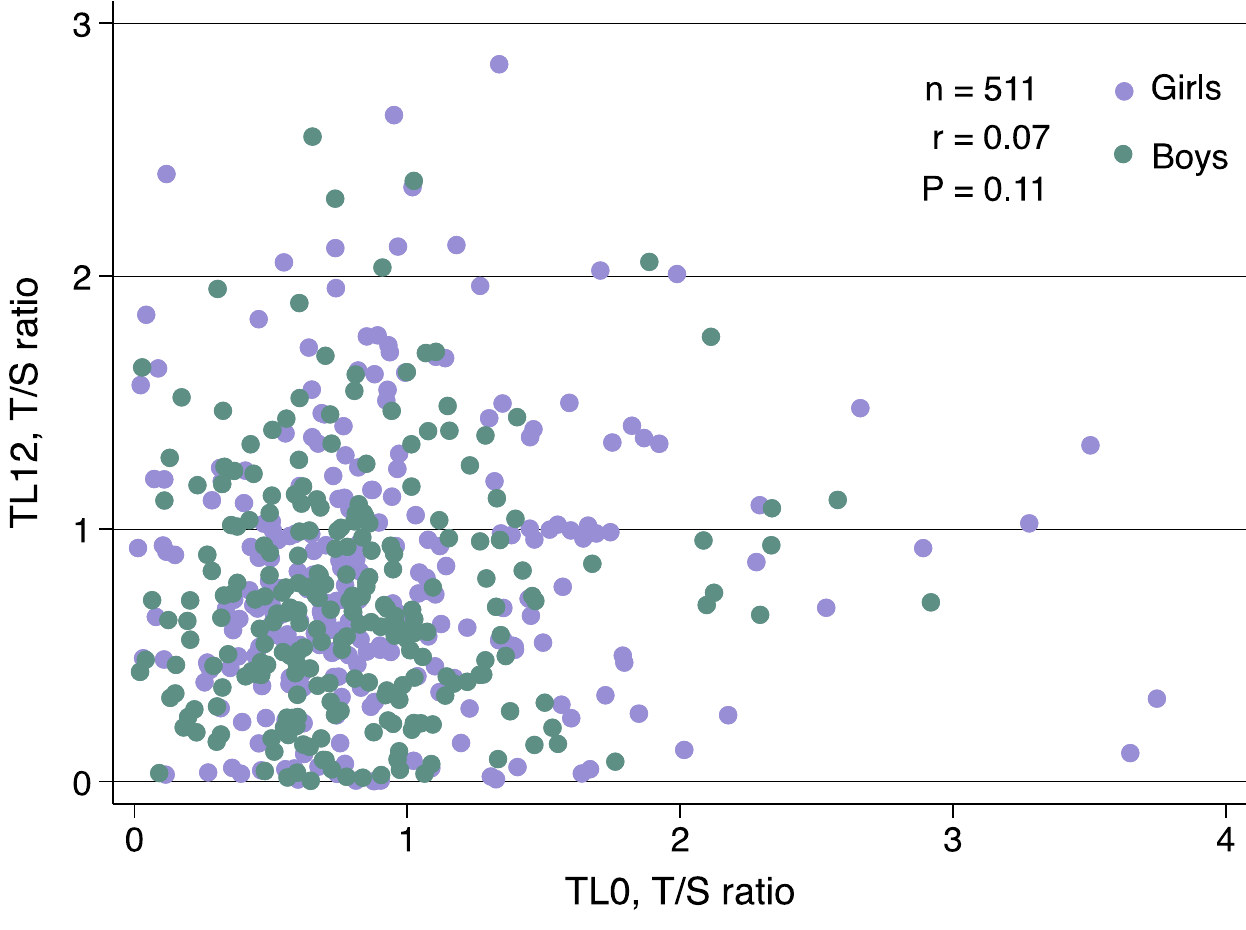
Figure 2. Telomere length distribution in infancy. Spearman correlation (r) between cord blood TL at birth and peripheral TL at 12 months. T/S ratio—telomeric genomic DNA/ β -globin single-copy gene; TL0—telomere length at birth; TL12—telomere length at 12 months.